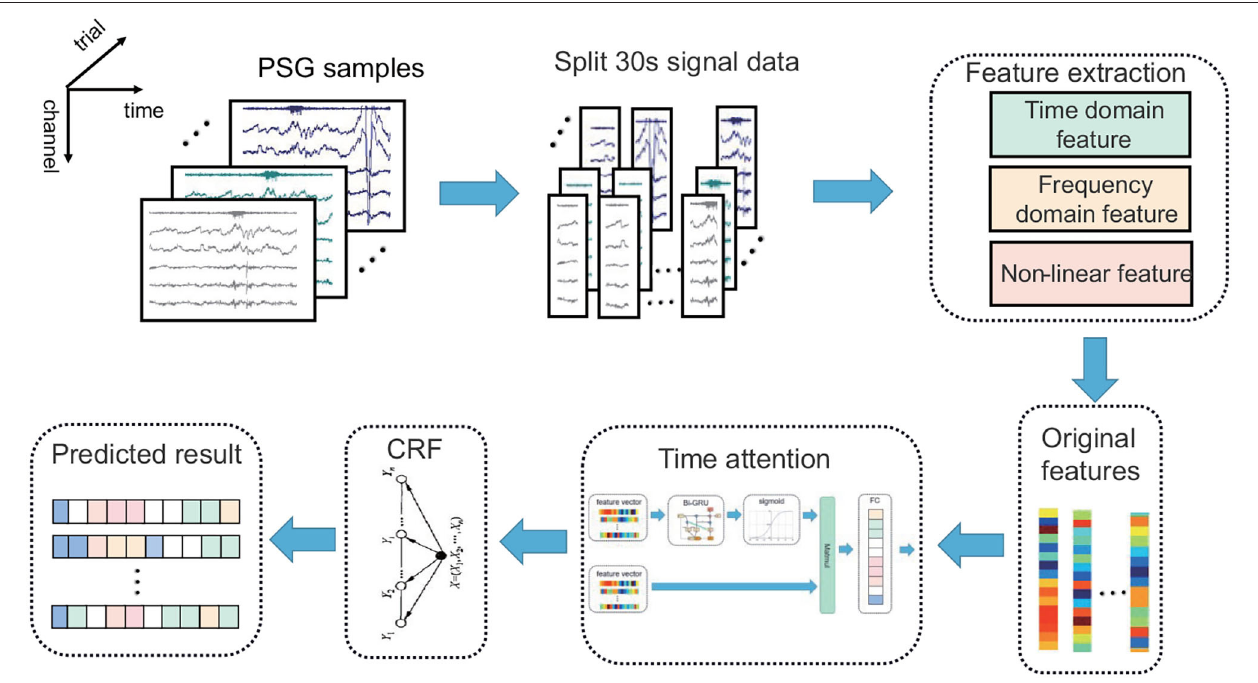
FIGURE 1 | The architecture of the automatic sleep stage classification model based on the time attention mechanism combined with the CRF model. The PSG is divided into 30-s epochs; the original features are obtained via feature extraction, and the prediction results are obtained by the time attention mechanism combined with the CRF